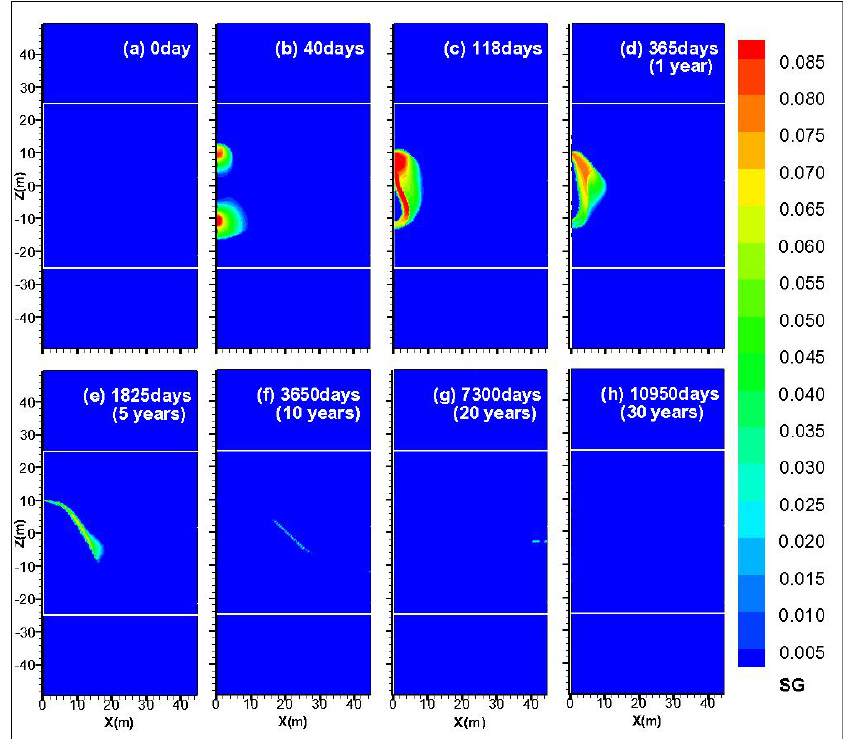
Figure 7. Evolution of the spatial distribution of S Reference